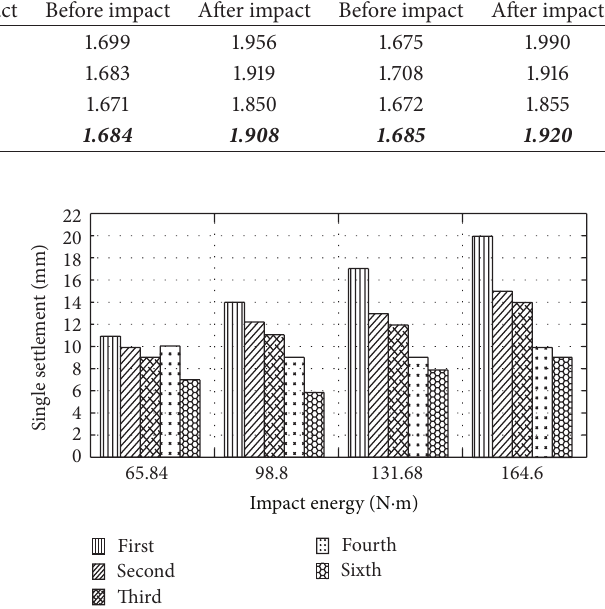
Figure 3: Relationship of impacted hole depth with impact